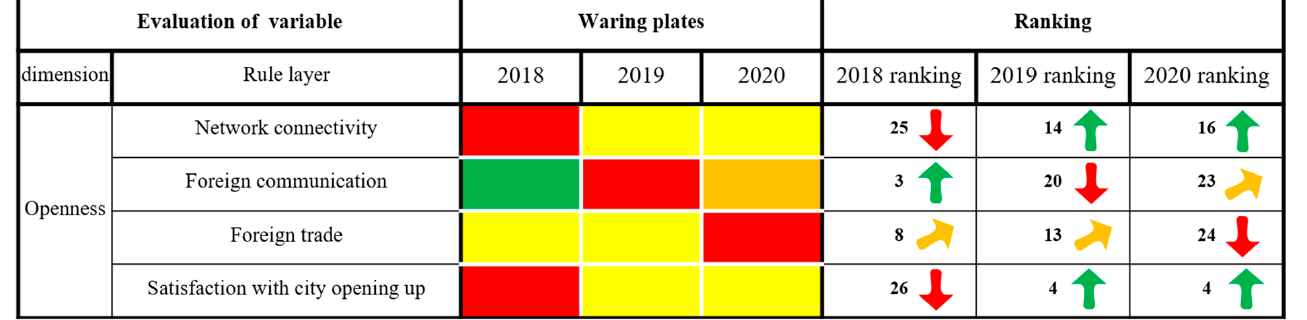
Figure 10. The results of the openness dimension of city health examination and evaluation in Xining City.